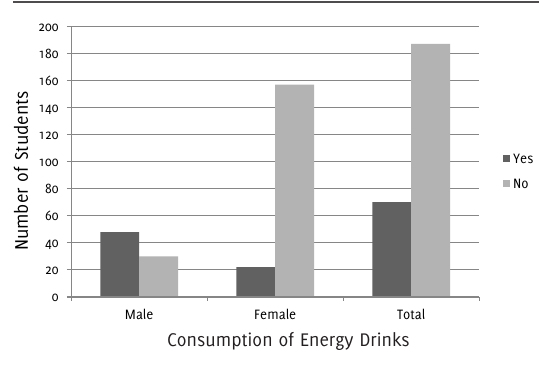
Figure 1. Prevalence of Energy Drink Consumption among Medical Students in Clinical